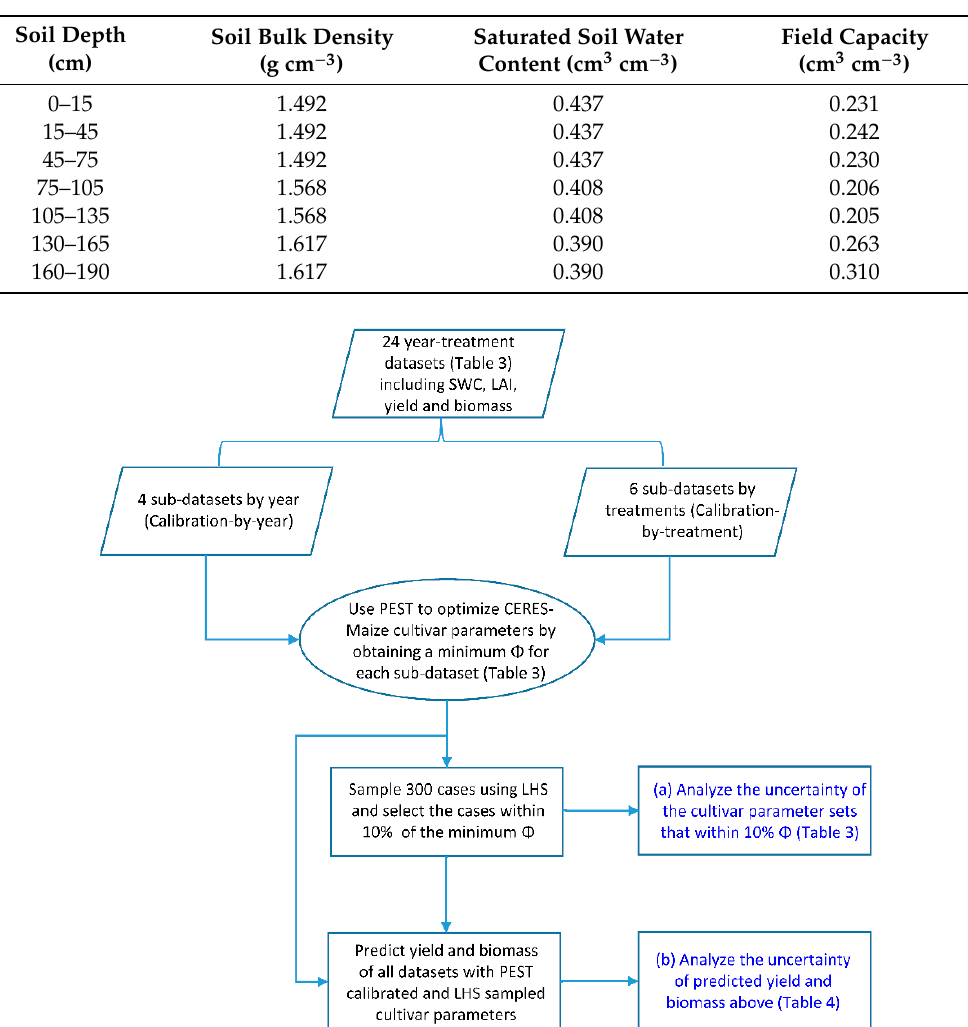
Figure 1. A schematic diagram for quantifying the uncertainty of crop parameters in CERES-Maize model and model predictions of yield and biomass for all the 24 year-treatment datasets (including soil water content (SWC), leaf area index (LAI), grain yield and biomass) in Table 3.